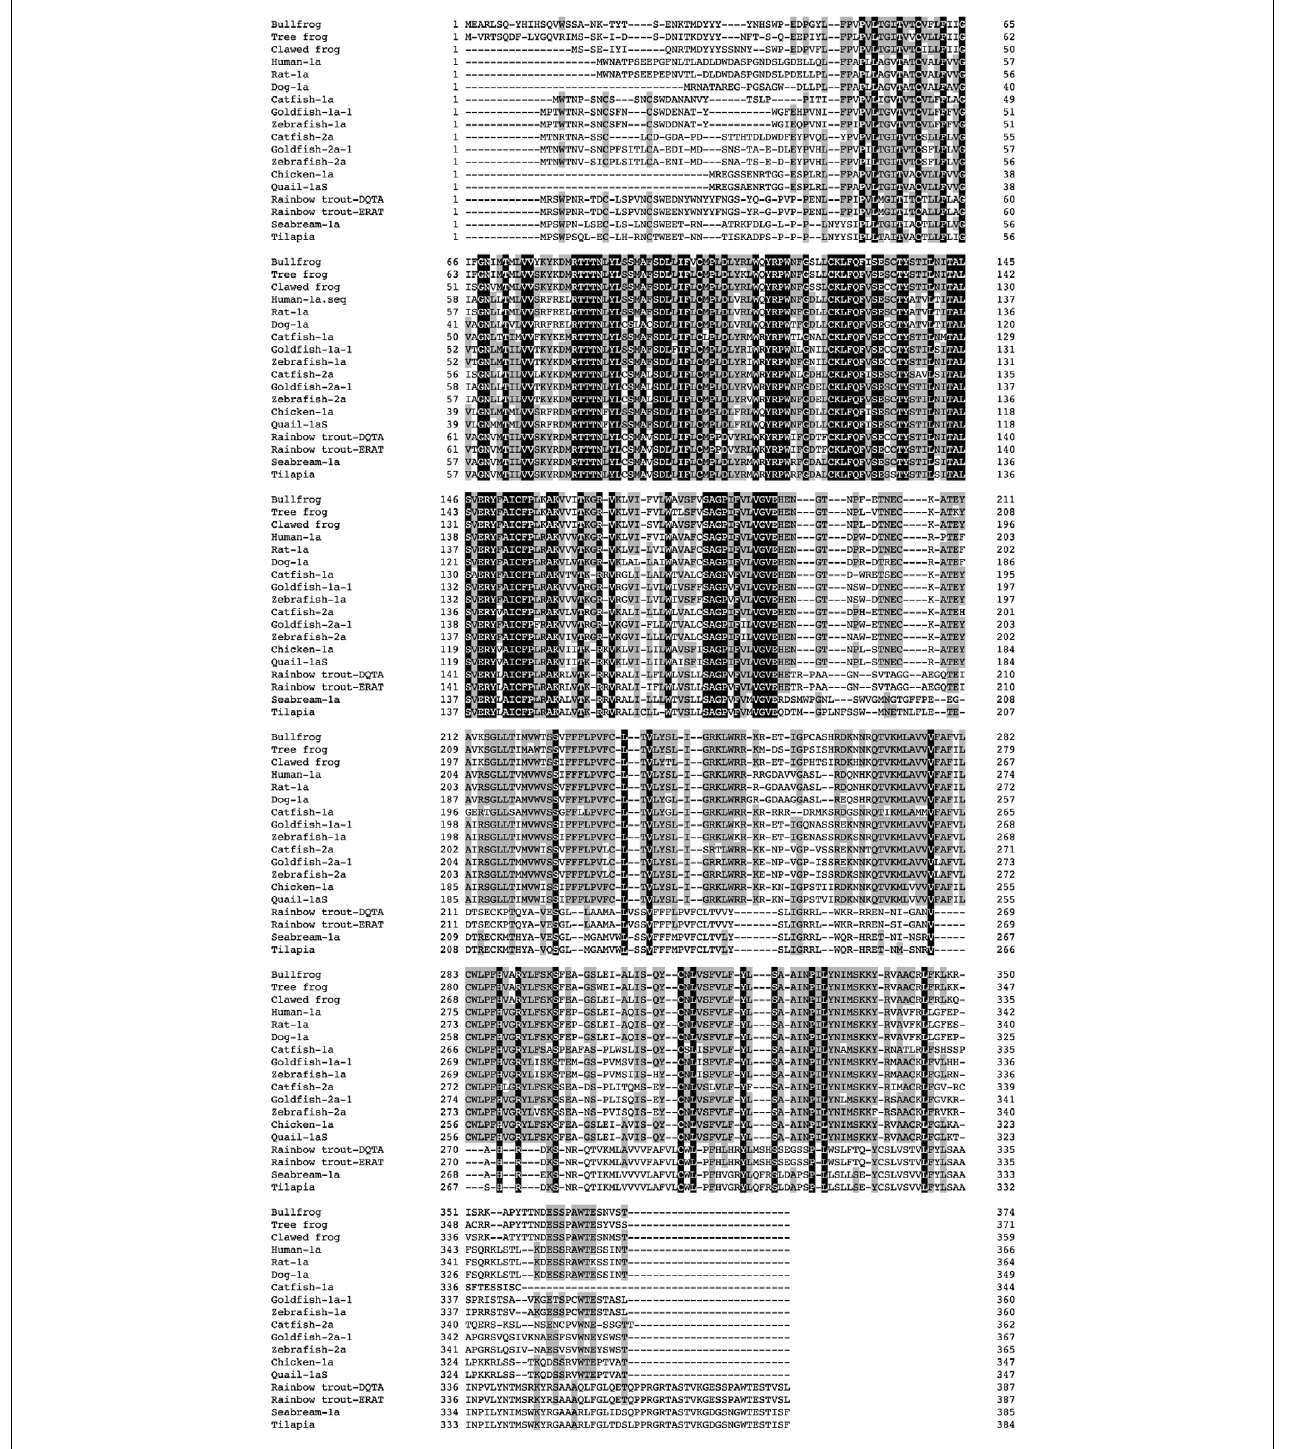
(NM_001099945), catfish-1a (FJ707319), goldfish-1a-1 (AB504275), zebrafish-1a (XM001335981), catfish-2a (FJ707320), goldfish-2a-1 (AB504277), zebrafish-2a (XM001340372), chicken-1a (AB095995), quail-1aS (AB469019), rainbow trout GHSR1a-like receptor (GHSR1a-LR)-DQTA (AB362479), rainbow trout GHSR1a-LR-ERAT (AB362480), seabream-1a (AY151040), tilapia GHSR1a-LR